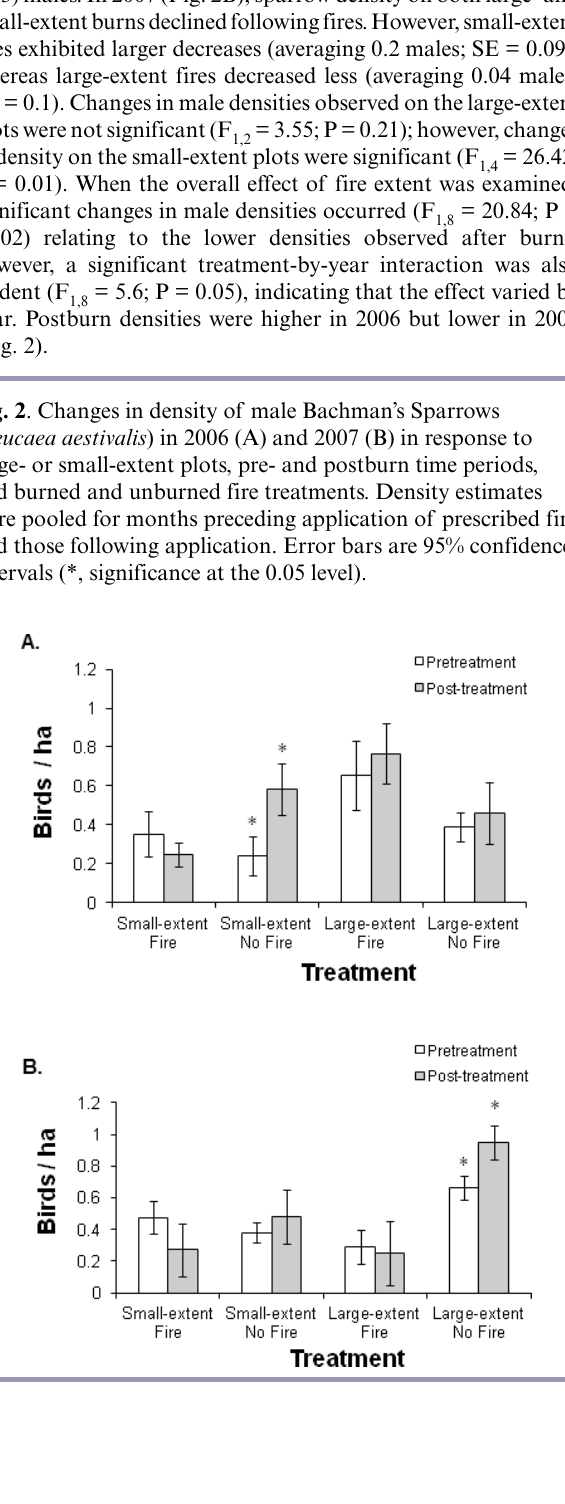
Table 1 . Top models for predicting reproductive status